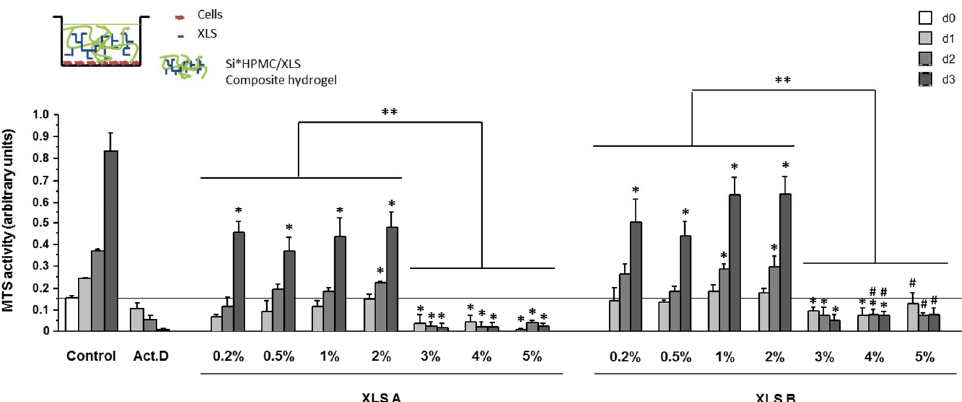
Figure 7. MTS activity of SW1353 cultured in 2D. hASC viability was evaluated in 2D after molding Si-HPMC hydrogels with 0 to 5% XLS (protocol A (XLS A) and B (XLS B)), as indicated on top of the cell layer (10,000 cells/cm2). As described in materials and methods, a MTS assay was performed at day 0, 1, 2, 3. Negative control (Act.D) was obtained by growing hASC in the presence of actinomycin D (5 µ g/mL). * p < 0.01 vs. d0; ** p < 0.01 between the indicated groups; # p < 0.01 vs. XLS A at the same % and same day.